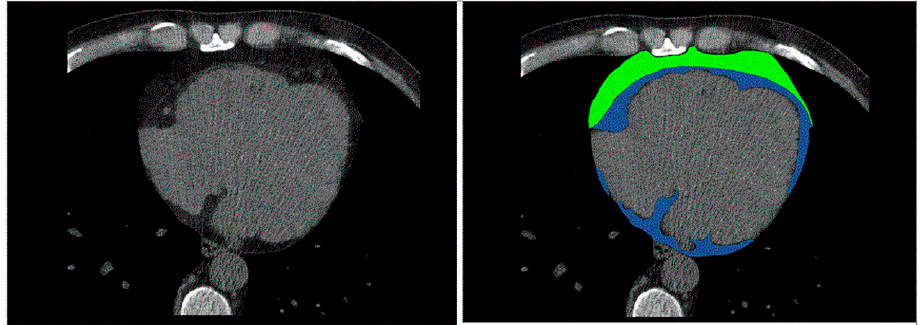
Figure 2. Cardiac Computed Tomography: EAT (depicted in blue) is located between the myocardium and visceral pericardium, PAT (depicted in green) is located adherent and external to the parietal pericardium. EAT: epicardial adipose tissue; PAT: pericardial tissue. de Wit-Verheggen VHW, et